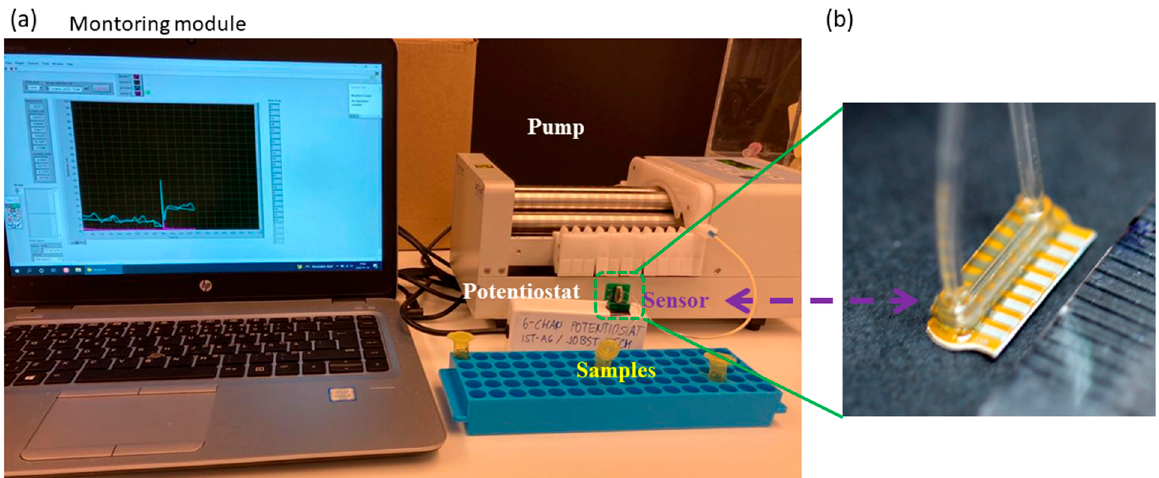
Figure 2. ( a ) Experimental setup for detecting glucose and lactate in the samples using the flow-through biosensor. ( b ) Image of the utilized B.LV5 flow-through sensor for lactate and glucose measurement in this study. A ruler on the lower right shows millimeter markings demonstrating the size of the sensor, i.e., with the flow cell it is just under one cm.